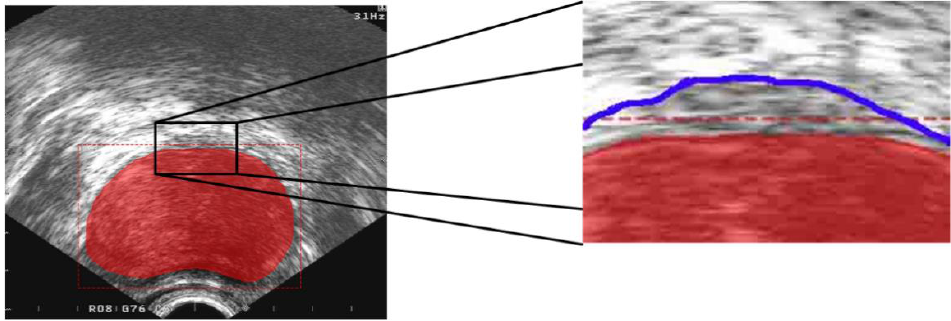
Figure 5. The border of the target area is inside the contour of the prostate. The blue line represents the outer contour of the prostate and the red dotted line represents the outer boundary of the target area.